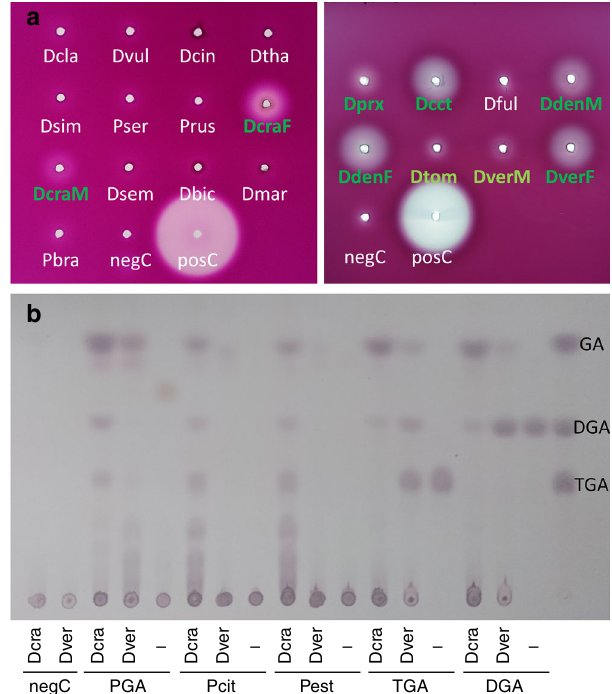
Fig. 5 In vitro pectinase activity assays with gut extracts from different reed beetles. a Agar diffusion assays for polygalacturonase activity; gut extracts exhibiting clearly visible enzymatic effects are highlighted in dark green, those with weak activity in light green (Dcla Donacia clavipes ,